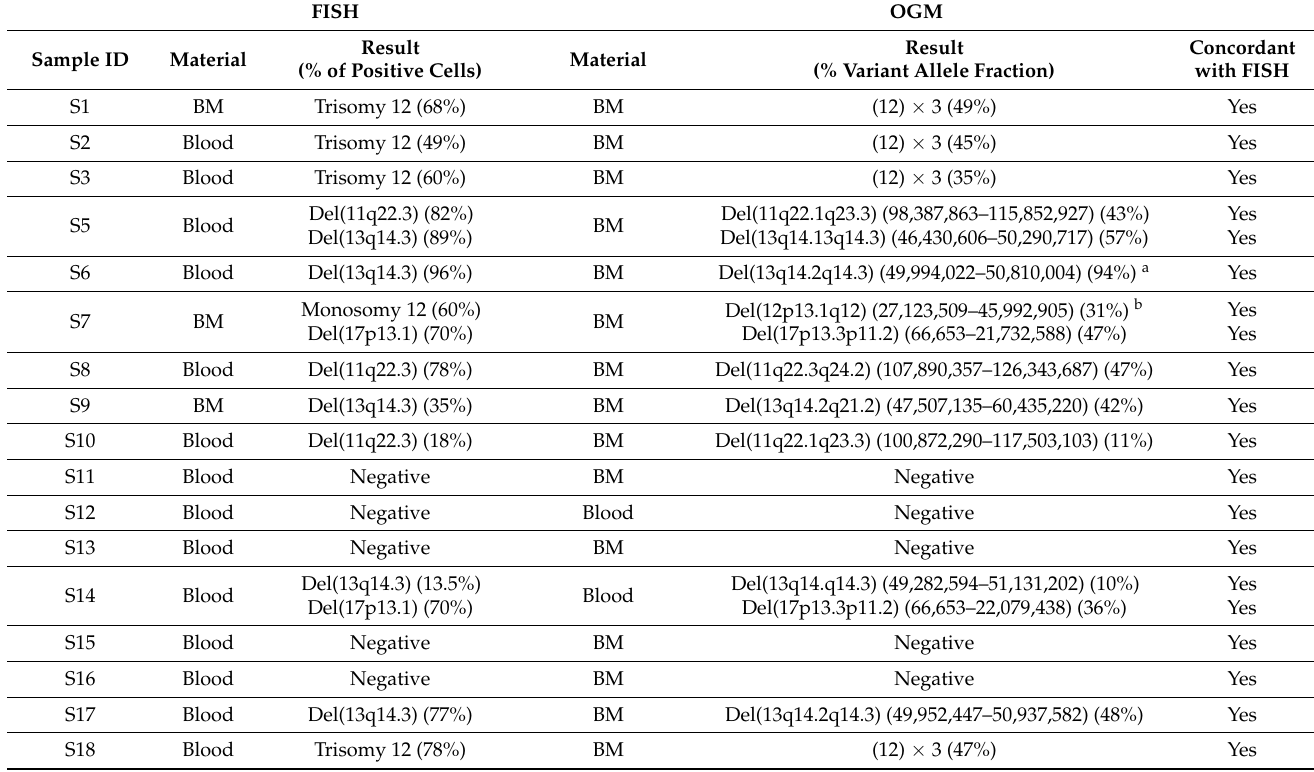
Table 1. OGM results compared to SOC FISH